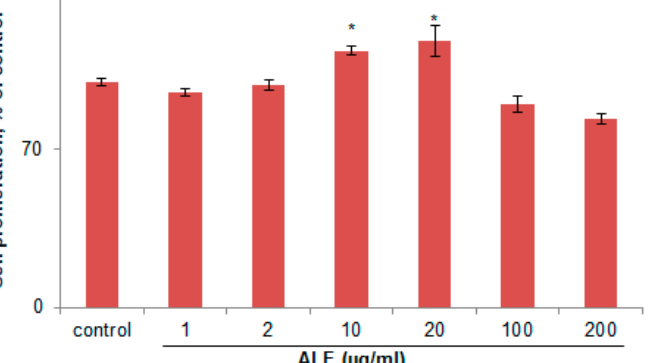
Figure 1. Cytotoxicity of argan leaves extract (ALE) on B16 cells. Cells were incubated with ALE at different concentrations (1, 2, 10, 20, 100, and 200 µg/mL) for 48 h. Values represent the percentage of cell proliferation relative to the control, expressed as mean ± standard deviation (SD) of three independent experiments. * Statistically significant ( p ≤ 0.05) versus the non-treated control (ANOVA, Tukey’s test).